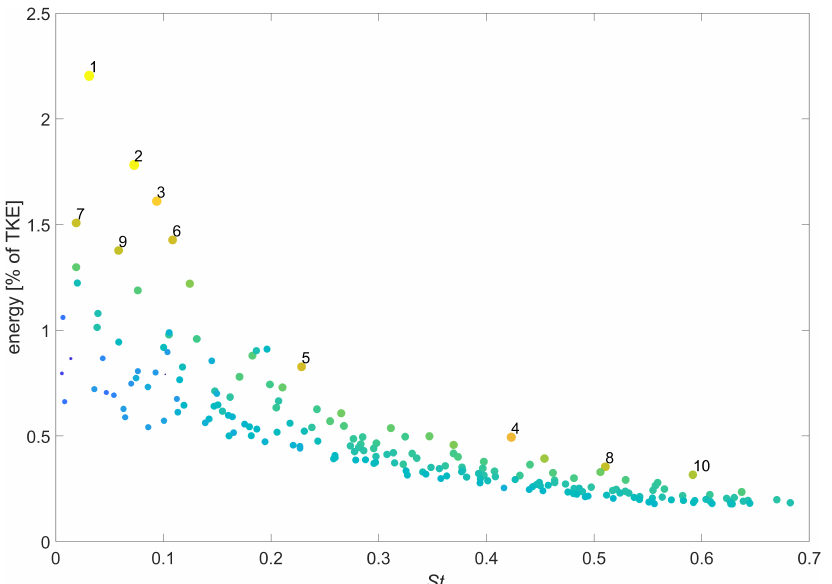
Figure 2. SPOD spectrum of ROM using the entire 3D data set, where the 10 mode pairs with the highest harmonic correlation are